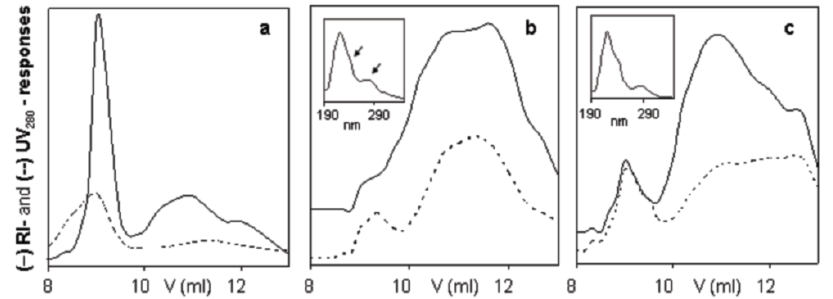
Figure 7. HPGPC chromatograms of beech wood xylan GX-3 suspended in 80% aqueous ethanol (a) before and after purification by sonication for 5 min at (b) pH 9 and (c) pH 7. Inserted are UV-spectra of the filtrates; the arrows indicate the absorption bands of unsaturated and phenolic